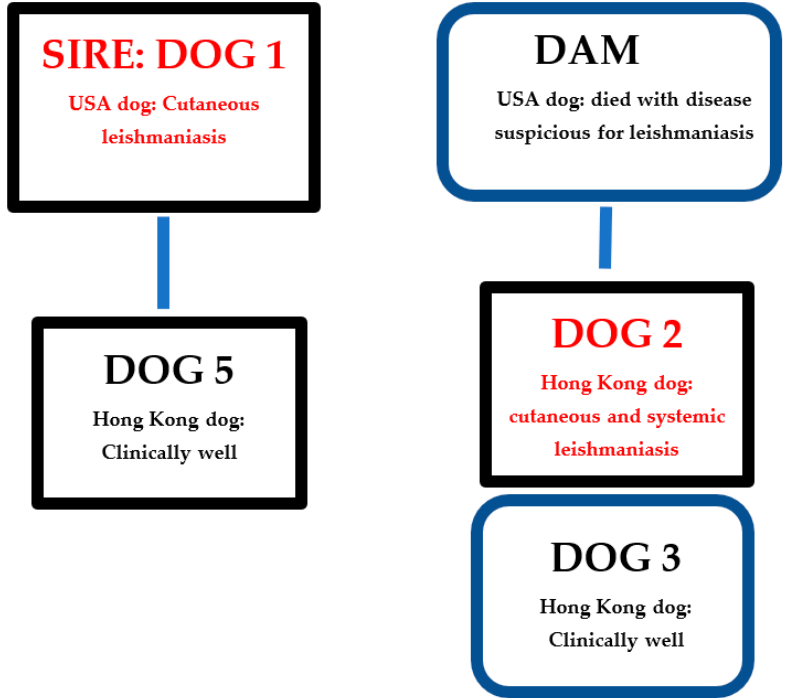
Figure 1. Leishmaniasis disease status and relationships of dogs within the Hong Kong kennel. USA: United States of America. Black rectangles: Male dogs. Blue rounded rectangles: Female dogs.